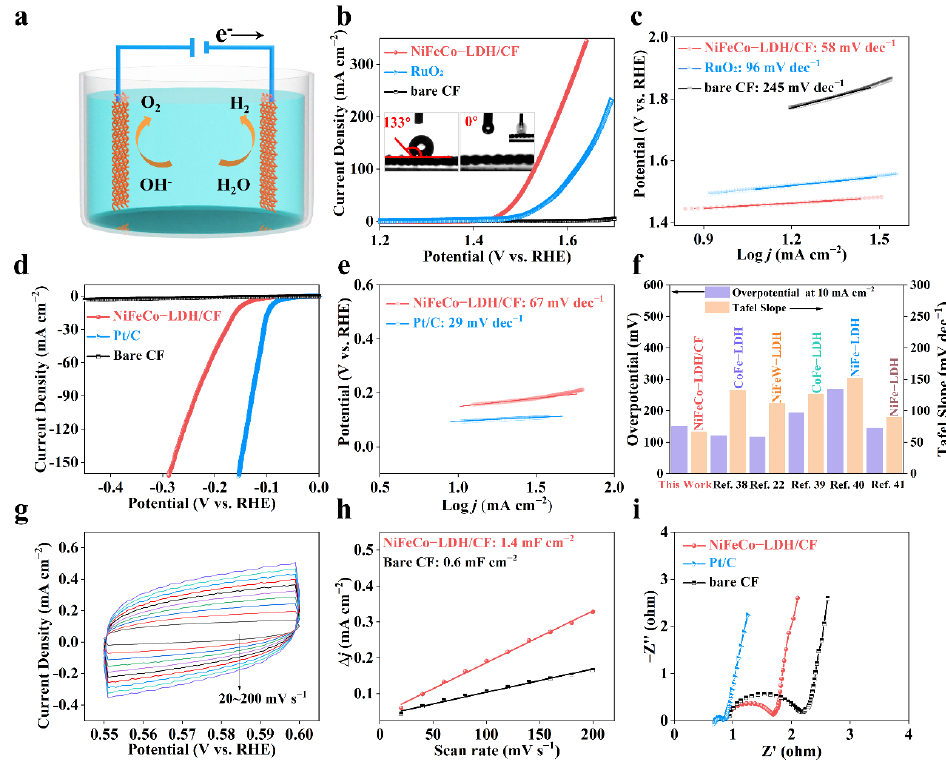
Figure 4. ( a ) Schematic diagram of electrocatalytic water splitting. ( b ) Oxygen evolution reaction (OER) performance of commercial RuO 2 , bare CF, and NiFeCo ‐ LDH/CF in 1.0 M KOH. The contact angles of bare CF and NiFeCo ‐ LDH/CF are illustrated. ( c ) Corresponding Tafel plots. ( d , e ) The LSV curves and Tafel slope of Pt/C bare CF and NiFeCo ‐ LDH/CF. ( f ) Comparison of HER performance in common LDH. ( g ) Cyclic voltammograms of NiFeCo ‐ LDH/CF. ( h ) Estimation of C dl by plotting the current density variation against scan rate to fit a linear regression. ( i ) Nyquist plots of the above electrocatalysts.